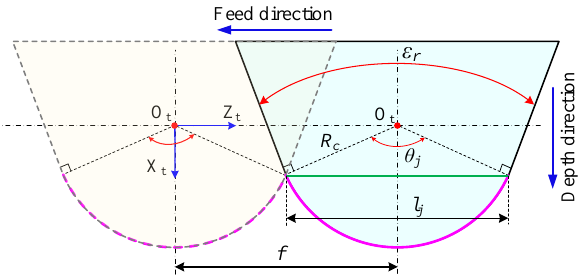
Figure 12. Illustration of the selection of critical feed rate ( f = l j ).